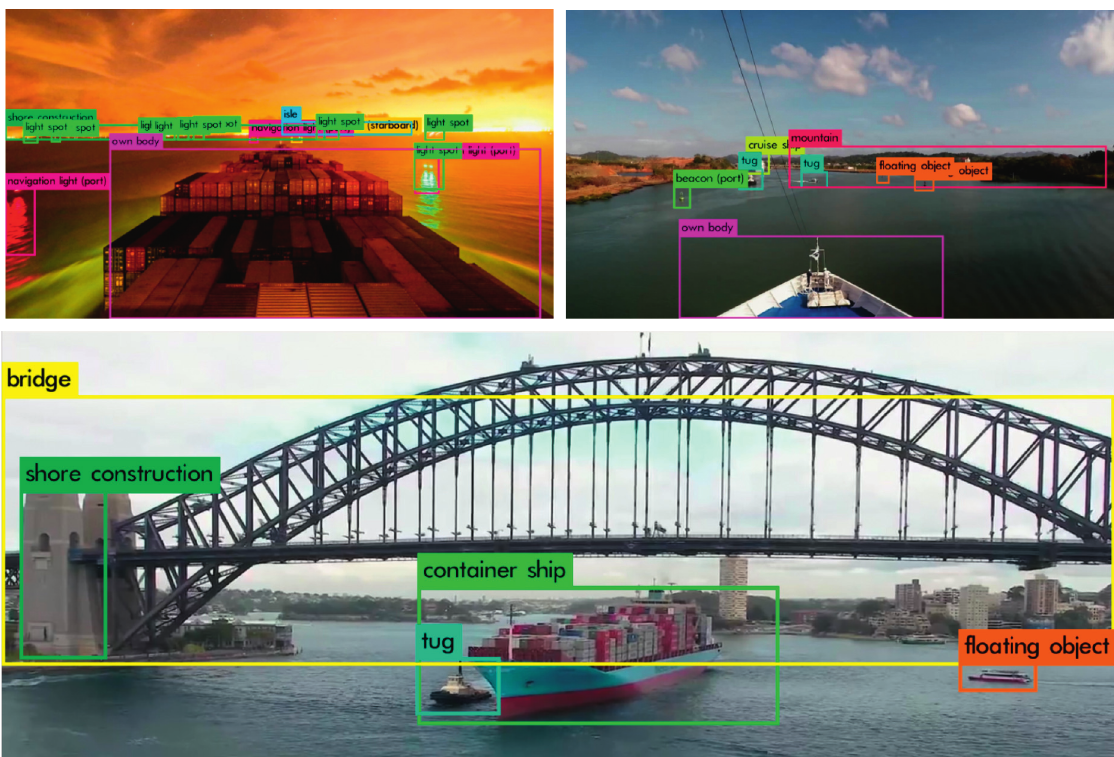
Figure 4: An example of onboard object